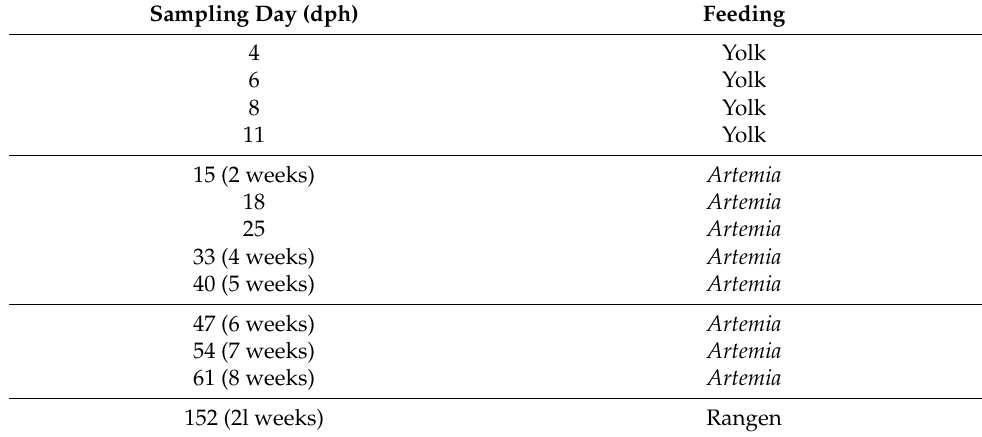
Table A1. Lake sturgeon sampling days and feeding schedule. Samples ( n = 10–12) were taken at each listed time given in days post-hatch (dph) from each water treatment. Starting at 47 dph, fish were sampled from Warm Springs National Fish Hatchery